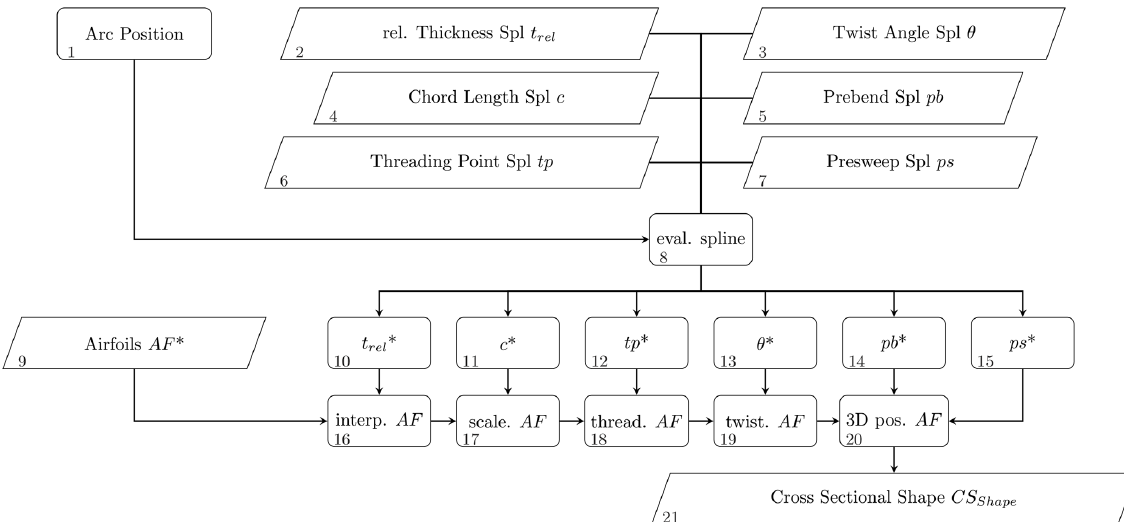
Figure 2. Flowchart of the calculation of the cross-sectional shapes CS Shape .